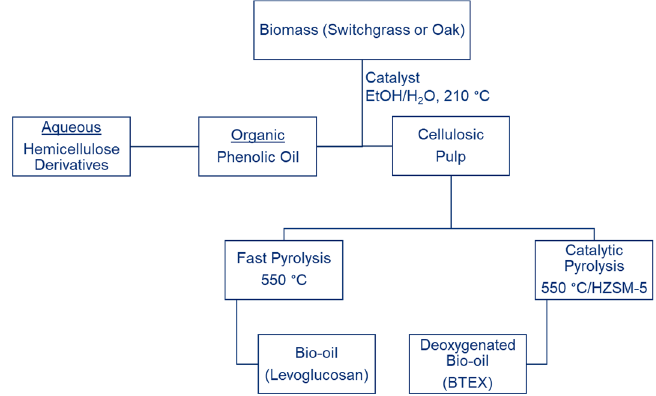
Figure 1. Schematic of biomass conversion process of this study.